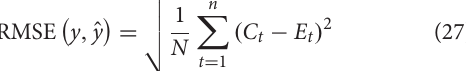
Frontiers in Energy Research |